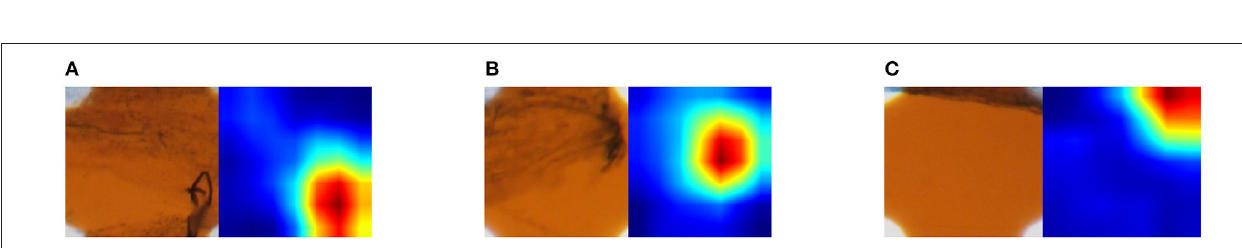
Frontiers in Plant Science |